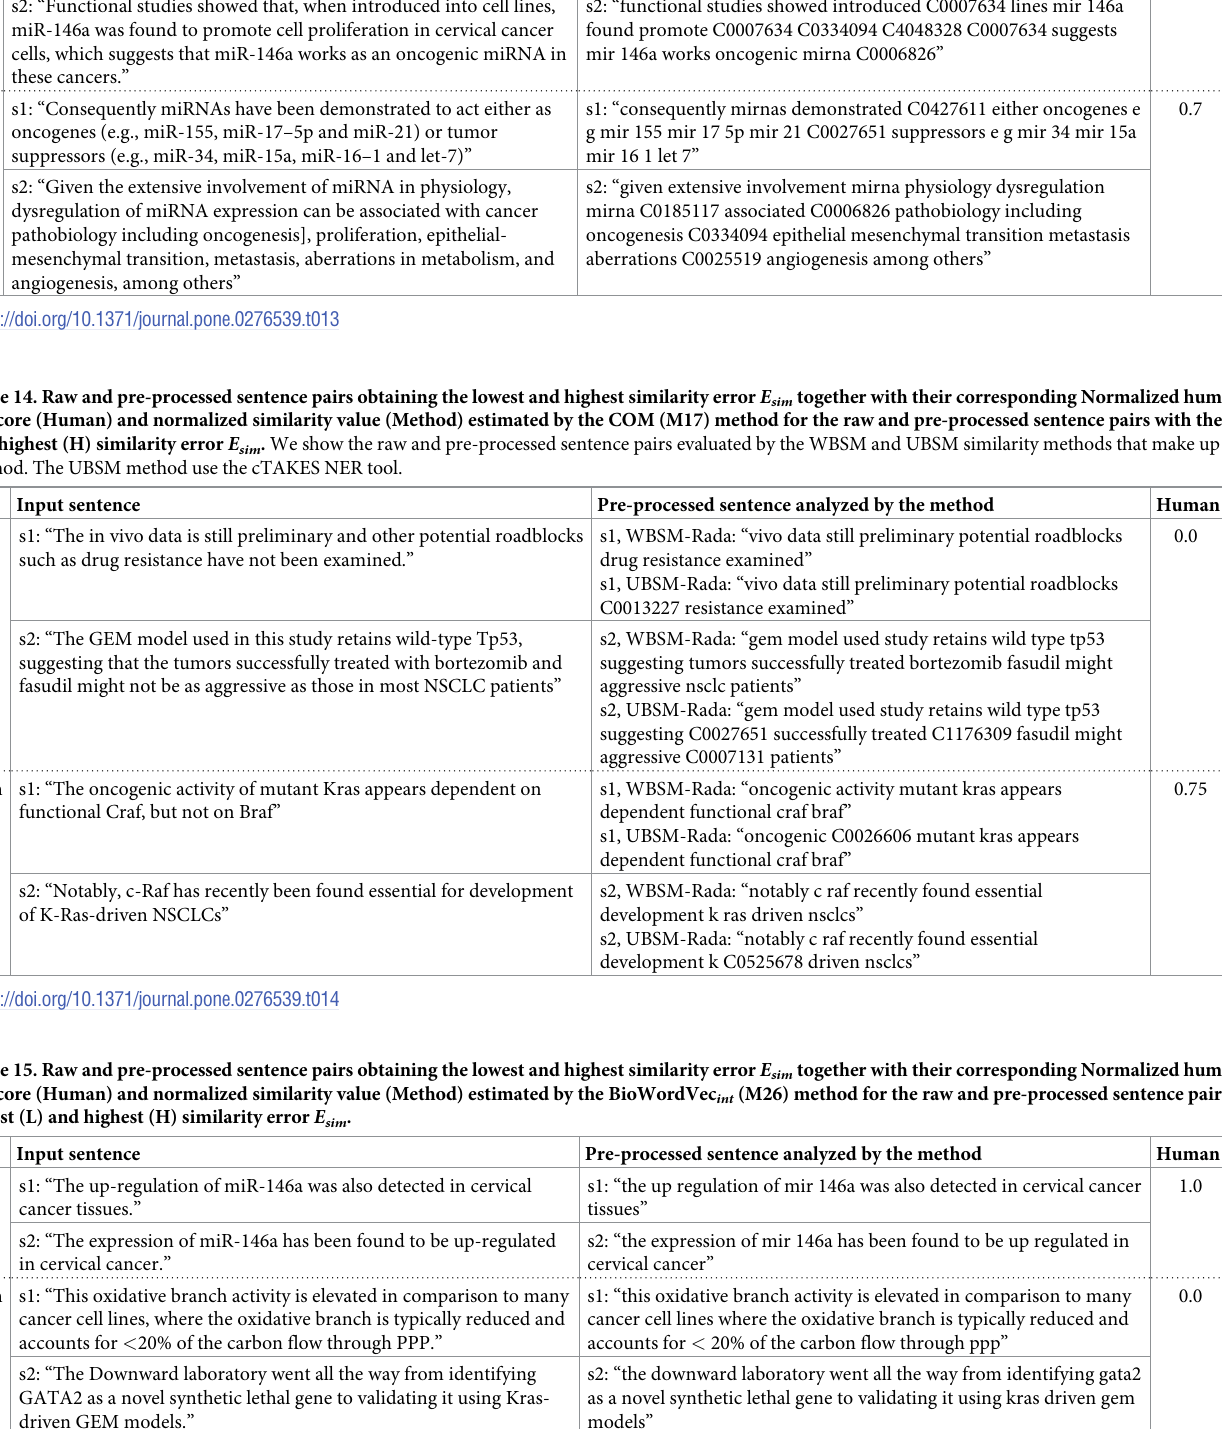
together with their corresponding Normalized human similar- sim